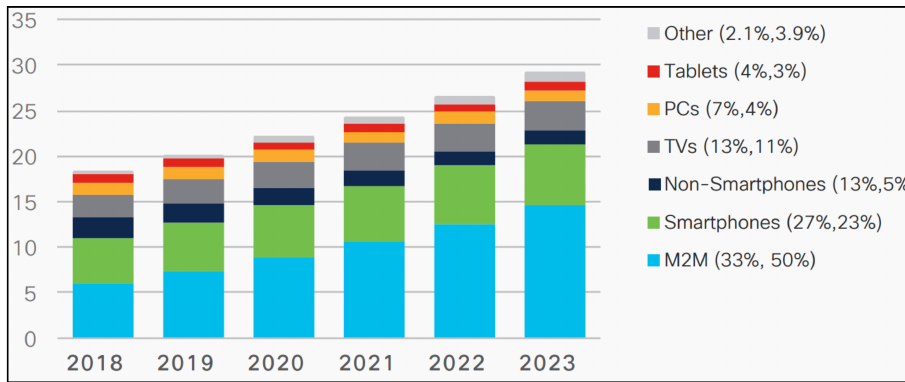
Figure 1. Global device and connection growth (Source: Cisco Annual Report, 2018–2023